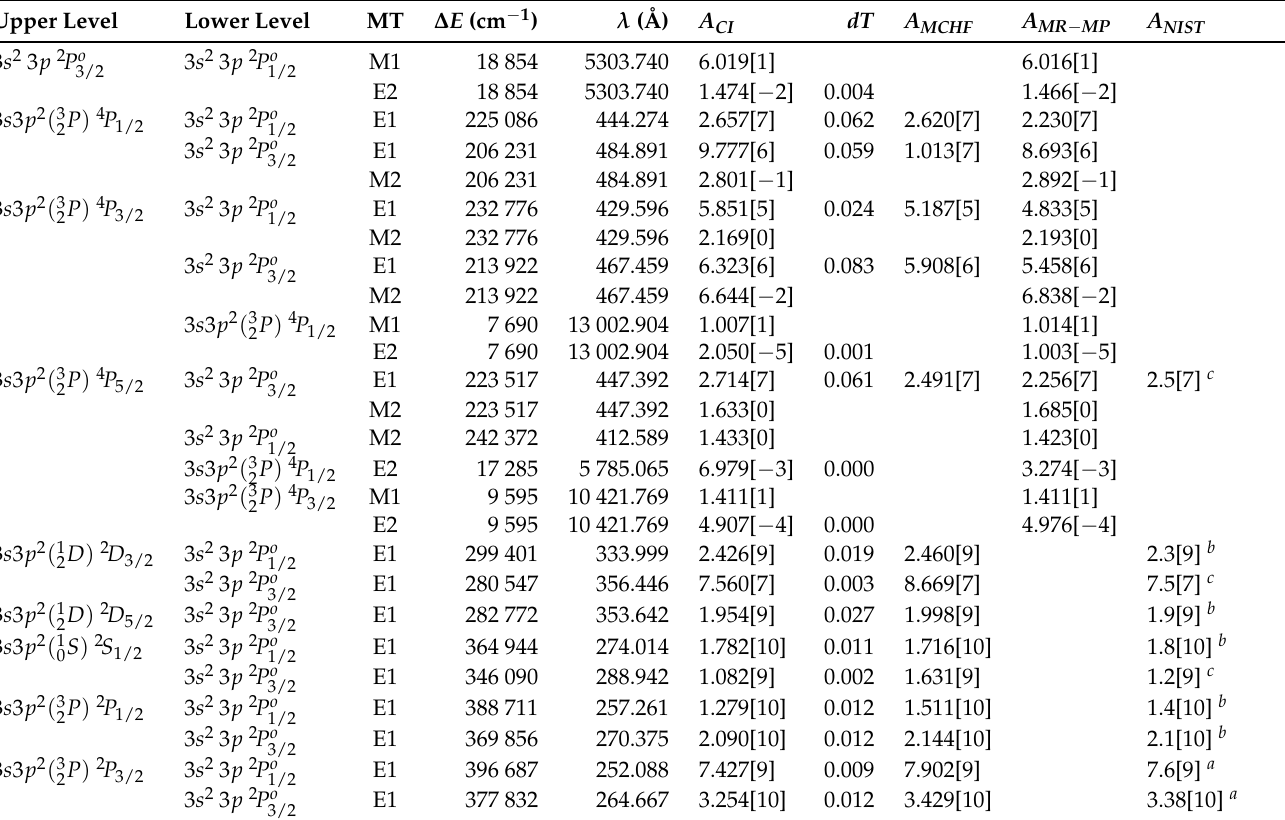
Table 9. Multipoles (MT), transition energies ∆ E , wavelengths λ and transition probabilities A in s − 1 in Fe XIV for selected transitions. A CI Ekman et al. [167], A MCHF Froese Fischer and Tachiev [170], A MR − MP Santana et al. [171], and A NIST NIST Atomic Spectra Database (2013) [168]. Accuracy estimates dT have been computed based on transition probabilities in Babushkin and Coulomb gauges. The numbers in square brackets are powers of